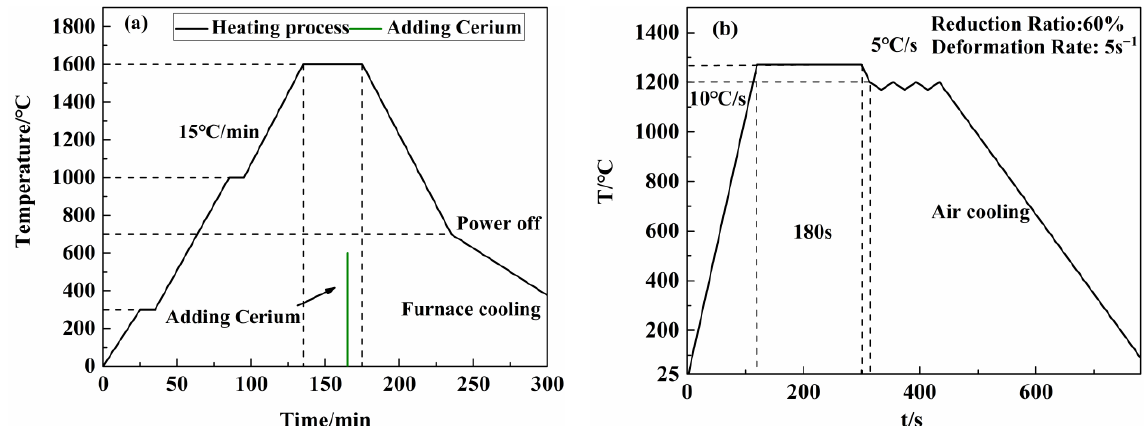
Figure 2. Temperature setting, ( a ): resistance furnace; ( b ): gleeble − 3500 simulated rolling mill. Table 1. Chemical composition of U75V steel